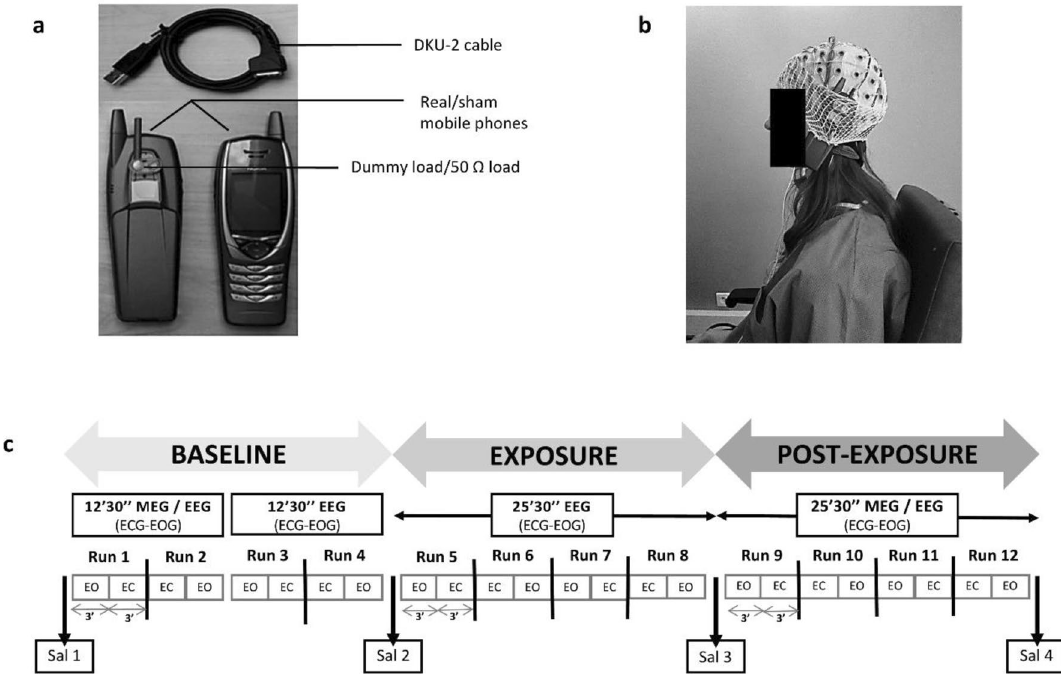
a tubular tissue bandage during the exposure. Each recording session included three phases: the baseline phase, with 12 min and 30 s of magnetoencephalography (MEG) and electroencephalography (EEG) simultaneously recorded and 12 min and 30 s of EEG recording; the exposure phase with 25 min and 30 s of EEG recording; the post-exposure phase with 25 min and 30 s of MEG and EEG combined recordings. Recording runs were performed with 3 min of eyes-open (EO) and eyes-closed (EC) sequences in alternation. After each run there was 30 s pause. Electrocardiogram (ECG) and electro-oculogram (EOG) were simultaneously recorded. Four saliva samples were collected (Sal 1, Sal 2, Sal 3, Sal